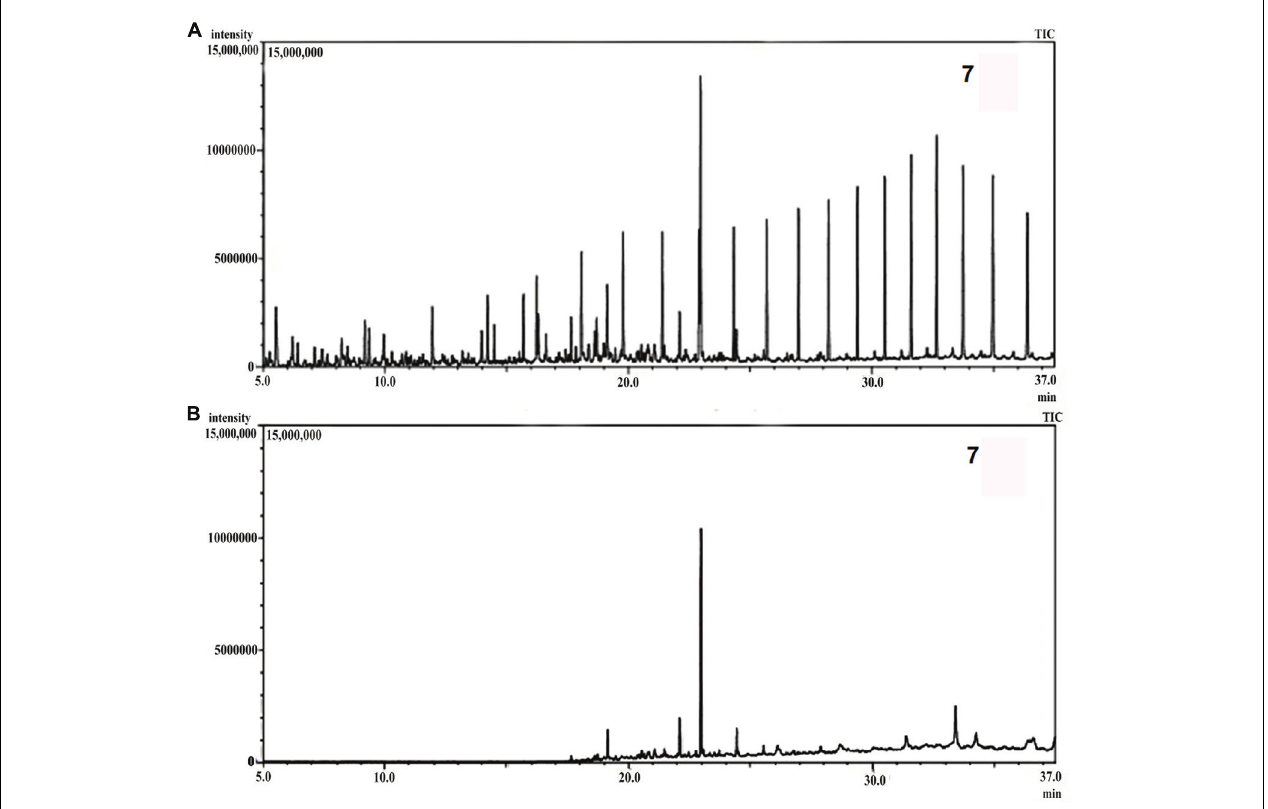
FIGURE 7 | (A) Gas chromatography-mass spectrometer (GCMS) chromatograph of abiotic control. (B) GCMS chromatograph of crude oil treated for 5 weeks with consortium